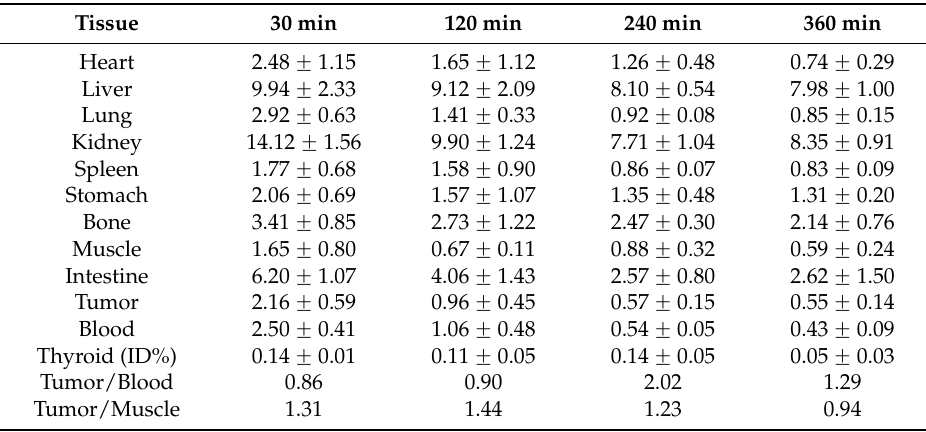
Table 1. Biodistribution of 7a in mice bearing S180 tumor (mean ± SD, n = 4, %ID/g).